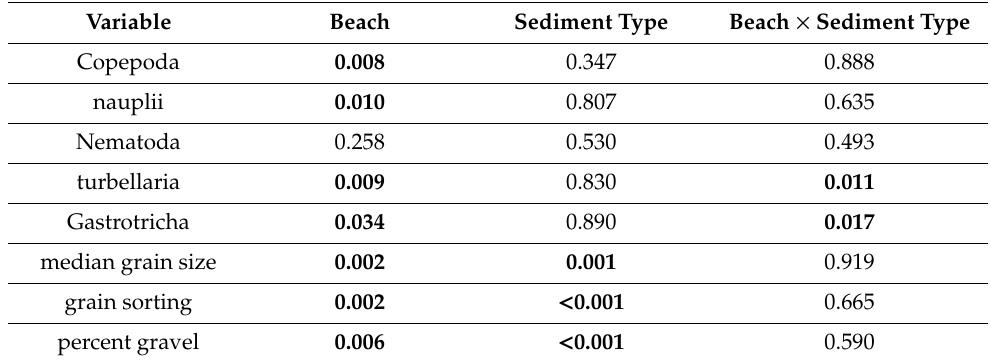
Figure 10. Univariate ( A – D ) comparisons of mean taxon abundances collected in low intertidal, surface finer and coarser sediment samples from four different beaches in 2006. Finer ( E ) and coarser ( F ) multivariate results are disaggregated to ease visual comparison; non-metric scales serve to ease visual estimation of dissimilarity distances but are not associated with any specific units. Table 4. Results of separate, 2-way Scheirer–Ray–Hare tests comparing faunal or granulometric variables collected from four Bogue Bank beaches spanning the length of the island with each beach having unique nourishment histories. Probabilities < 0.05 are in